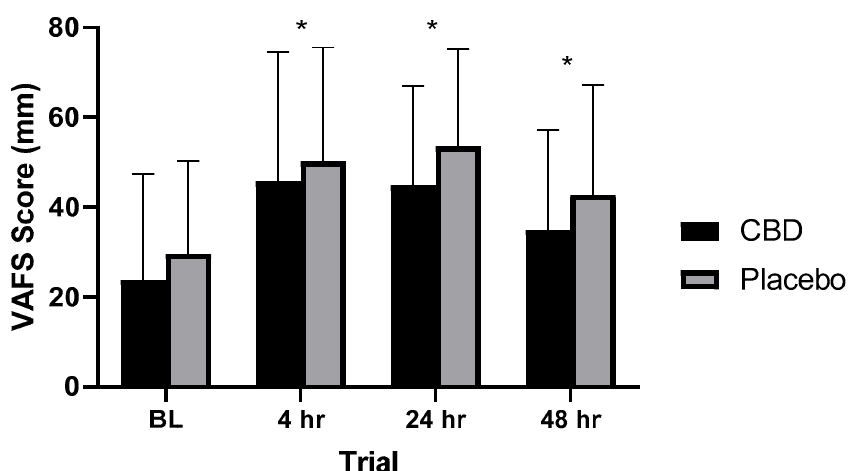
Figure 5. Visual Analog Fatigue Scale scores at various time points. * Statistically significant difference ( p < 0.05) observed from baseline measurement. BL = 2 h prior to muscle damaging protocol, 4 hr = 4 h post-muscle damaging protocol, 24 hr = 24 h post-muscle damaging protocol, 48 hr = 48 h post-muscle damaging protocol. ( n = 24).